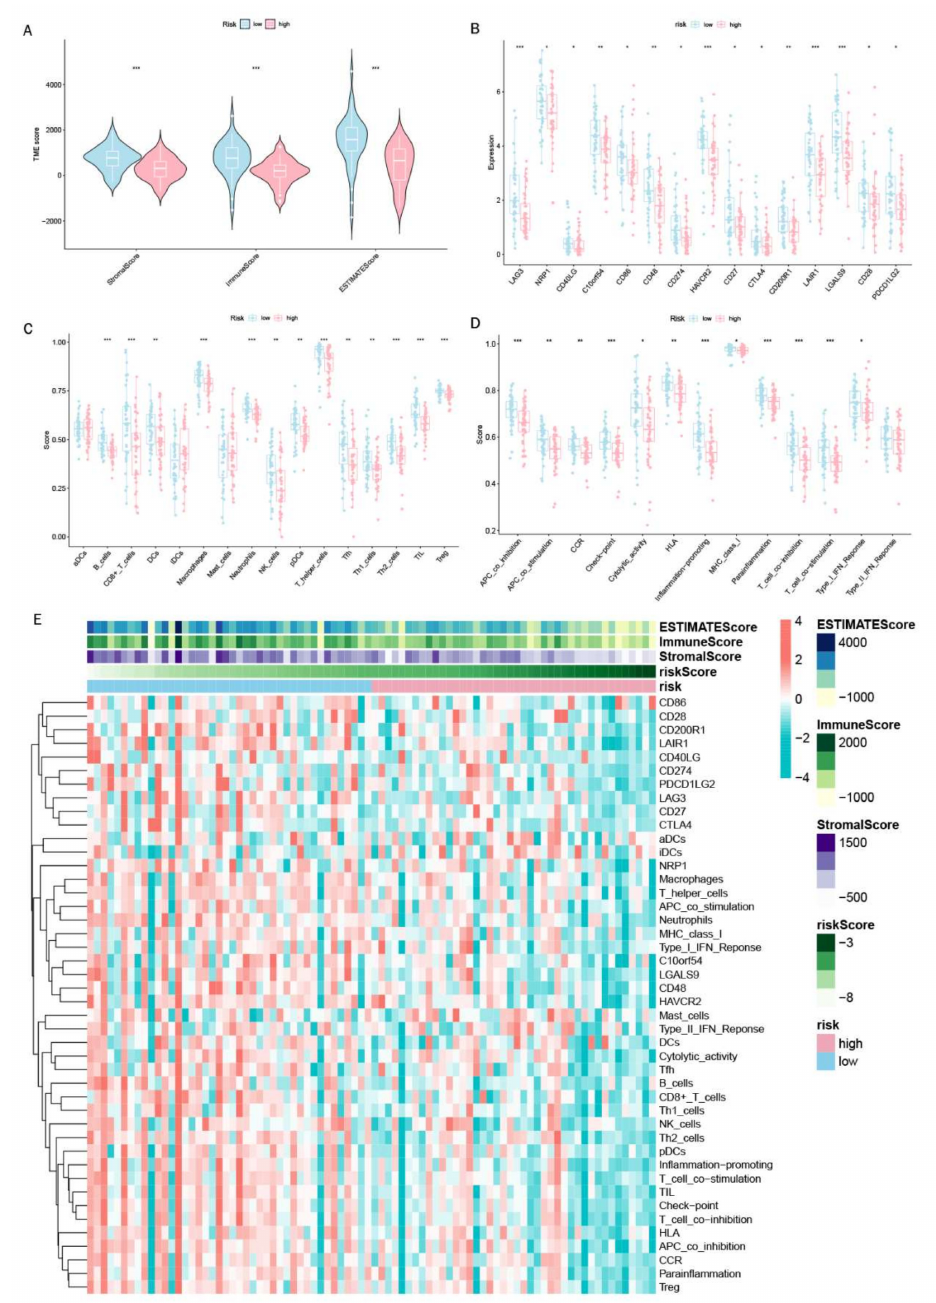
Figure 11. Immunoassay showing that DGPS is closely related to the immune system. ( A ) Analysis of TMB differences between high- and low-risk groups of patients with osteosarcoma. Box plots of the ssGSEA scores of 15 immune checkpoints ( B ), 13 immune cells ( C ), and 12 immune-related functions ( D ) between different risk groups. ( E ) Heatmap showing the landscape of immune characteristics and the tumor microenvironment in the TARGET cohort determined by the ssGSEA algorithm. “*”represented “ p < 0.05”,“**”represented “ p < 0.01”,“***”represented “ p <